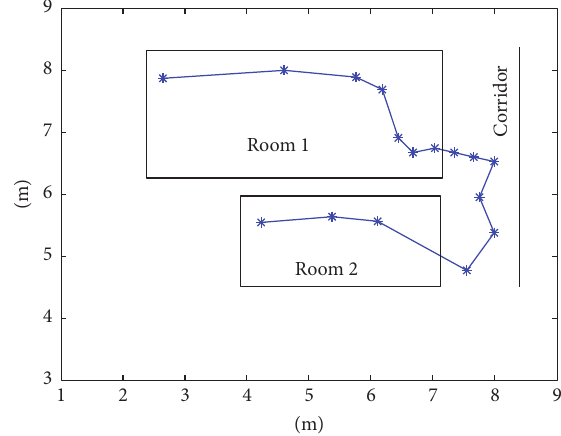
Figure 16: The global position relationship of keyframes sequence; “ ∗ ” is the position of each